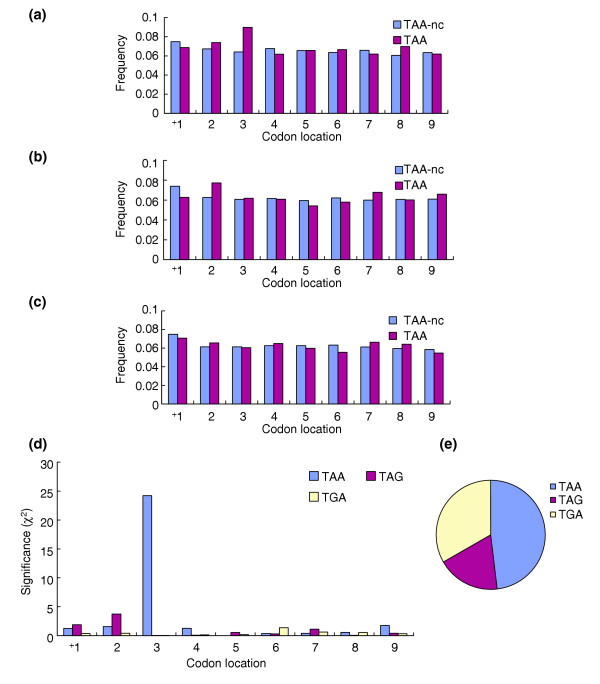
Frequency of stop codons at the downstream codon locations following the real stop codons (which occur at codon location '0') in S. cerevisiae. (a) TAA; (b) TAG; (c) TGA. The red bars represent the frequency of stop codons at each codon location and the blue bars represent the controls - the frequency of stop codons at the corresponding locations downstream of stop codons in non-coding regions (nc). (d) Statistical significance of stop codon frequency at each location following each stop codon. For each codon location in the analysis, the statistical significance (using χ2 tests) of the difference between the frequencies of tandem stop codons in the yeast genes and in the control sequences is shown. The blue bars represent codon locations following the stop codon TAA; the red bars represent codon locations following the stop codon TAG; the yellow bars represent codon locations following the stop codon TAA. (e) The identity distribution of three stop codons at the UAA+3 codon location. Blue represents the percentage of TAA; red represents TAG; yellow, TGA.